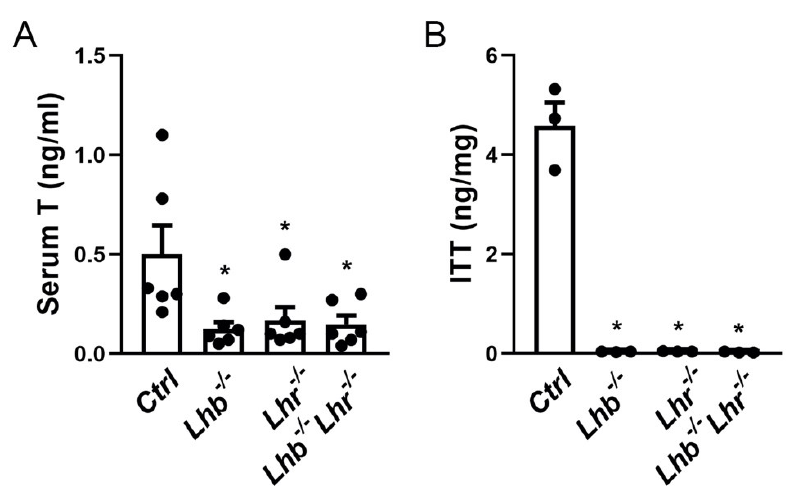
Figure 4. Serum and ITT assays in single and double mutants. Serum ( A ) and intratesticular T (ITT) ( B ) was quantified by an ELISA. Compared to Ctrl , both serum ( Ctrl = 0.5 ± 0.15 ng/mL; Lhb − / − = 0.13 ± 0.03 ng/mL; Lhr − / − = 0.17 ± 0.07 ng/mL; Lhb − / − Lhr − / − = 0.15 ± 0.04 ng/mL, * p < 0.05, One-way ANOVA, Ctrl vs. Lhb − / − , Lhr − / − or Lhb − / − Lhr − / − , n = 4–6 mice) and ITT ( Ctrl = 4.58 ± 0.04 ng/mg; Lhb − / − = 0.04 ± 0.003 ng/mg; Lhr − / − = 0.04 ± 0.003 ng/mg; Lhb − / − Lhr − / − = 0.03 ± 0.006 ng/mg, * p < 0.05, One- way ANOVA, Ctrl vs. Lhb − / − , Lhr − / − or Lhb − / − Lhr − / − , n = 4 – 6 mice) are significantly suppressed in single or double mutants. No additive effect of loss both LH and LHR are noted. The serum T and ITT values are not significantly different among single or double mutants ( p > 0.05, One-way ANOVA, Lhb − / − vs. Lhr − / − or Lhb − / − Lhr − / − , Lhr − / − vs. Lhb − / − Lhr − / − , n = 4 – 6 mice).